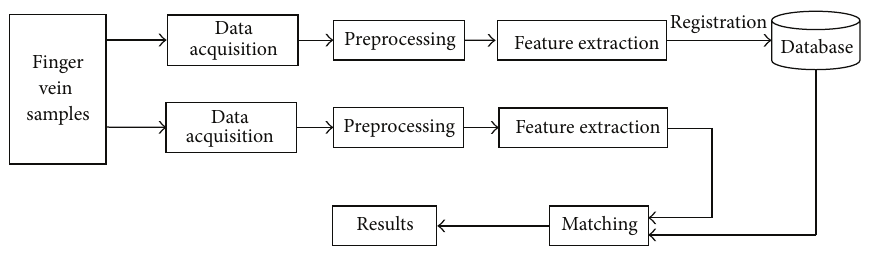
Figure 3: Biometric system structure